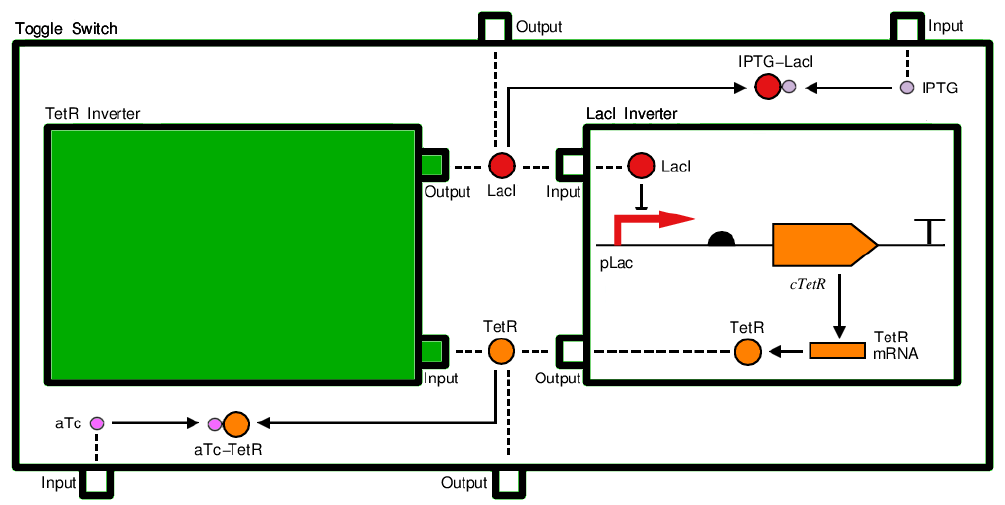
Figure 24: Design of a LacI/TetR toggle switch. This design is composed of two inverter sub-designs, each containing a single gene. These genes mutually repress each other’s expression via their encoded protein transcription factors, LacI and TetR. Furthermore, both LacI and TetR are bound by specific small molecules that sequester them and prevent them from acting as repressors. In this design, arrows represent different molecular interactions, including the repression of pLac via LacI, the non-covalent binding of IPTG to LacI, the transcription of TetR mRNA, and the translation of TetR. Dashed lines serve to map between transcription factors in the inverter sub-designs and those in the overall toggle switch design.